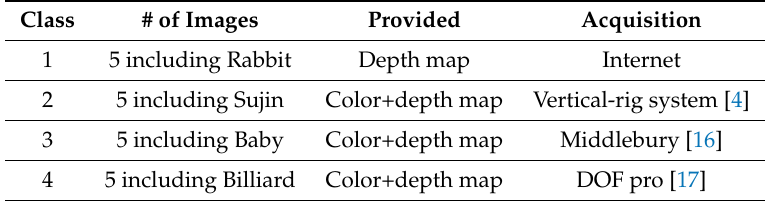
Table 1. Test images for